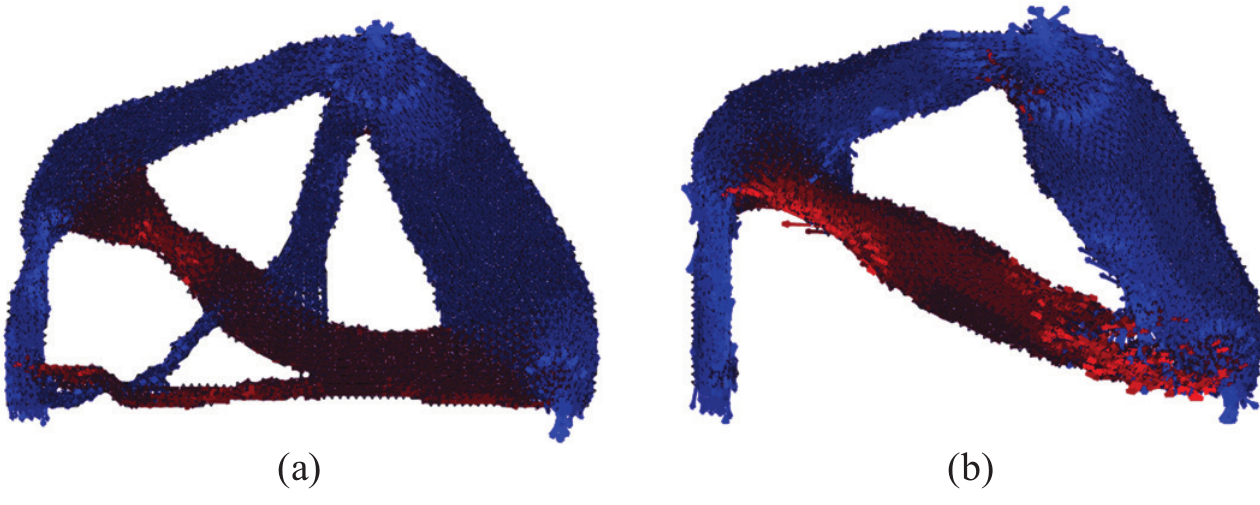
Optimum topologies by ESO and stress distribution obtained for the element, according to FEM (a) considering the linear and (b) non-linear